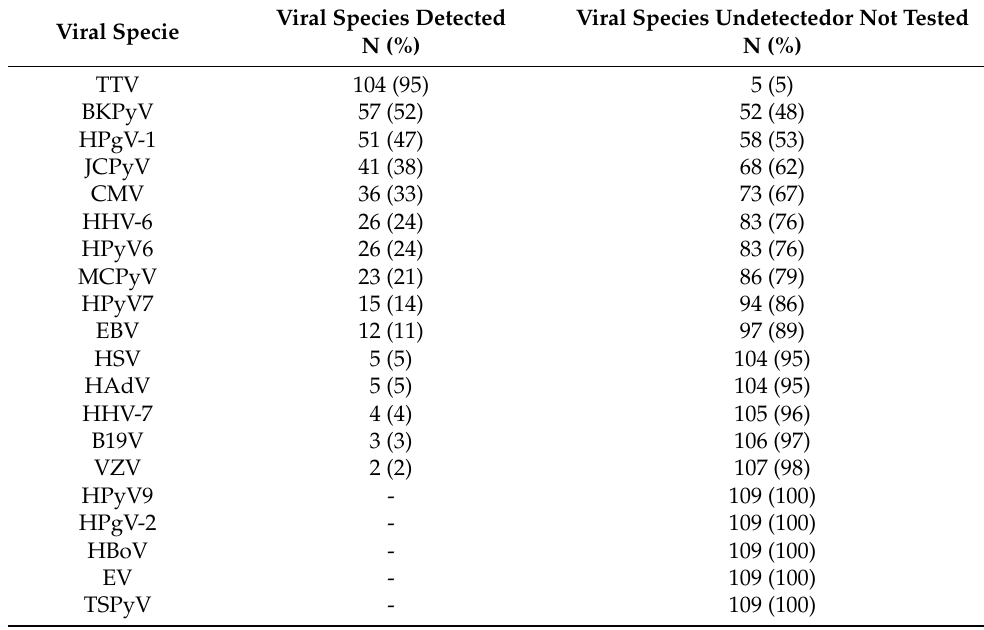
Table 3. Period prevalence (D0 to Y1) of 20 viruses in plasma samples of 109 HSCT recipients. Viral